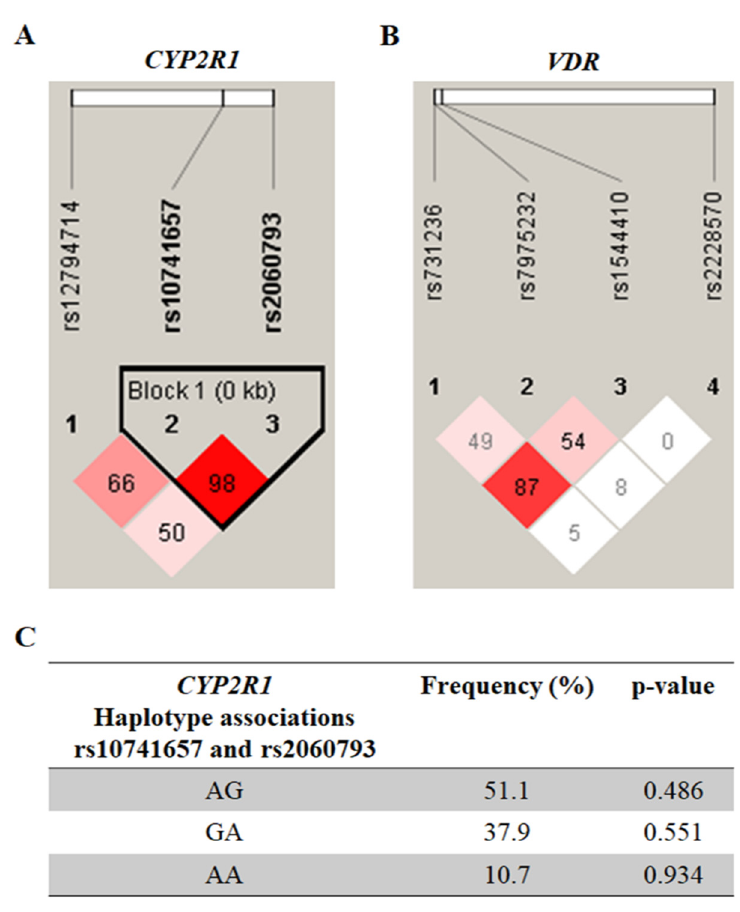
Figure 1. Pairwise linkage disequilibrium plot of CYP2R1 /rs12794714, rs10741657, and rs2060793 ( A ), as well as of VDR /rs731236, rs7975232, rs1544410, and rs2228570 ( B ) in the combined sample (cases & controls) showing r2 (×100) values. The block for CYP2R1 ( C ) is designed according to the internally developed solid spine of linkage disequilibrium (LD). The value within each diamond represents the pairwise correlation between pairs of single-nucleotide polymorphisms (SNPs) (measured as 100 × r2) defined by the upper left and upper right sides of the diamond. The frequency of each haplotype is shown below the blocks.